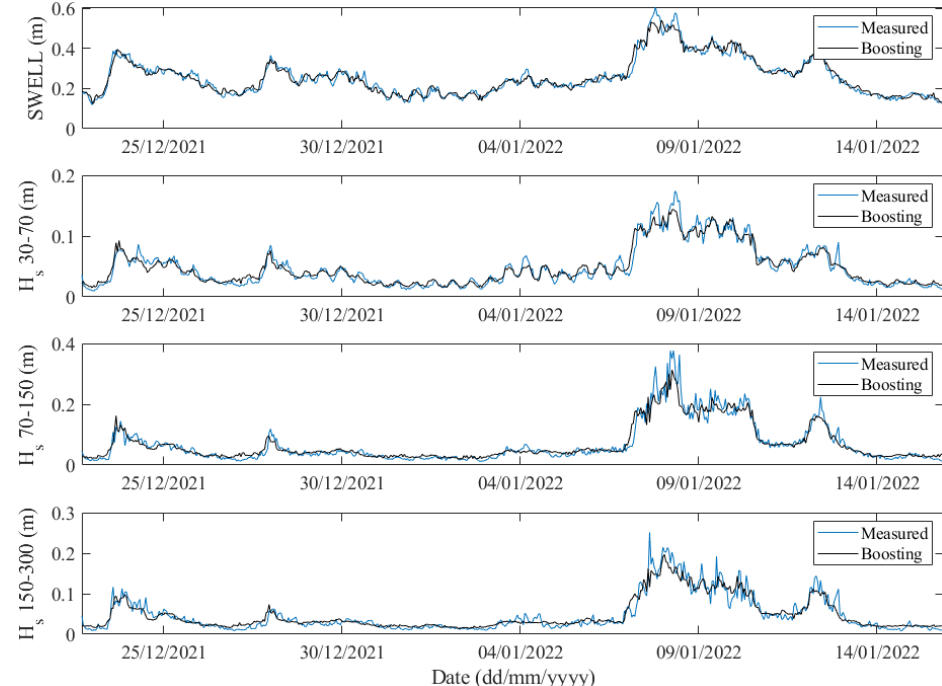
Figure 6. Measured and predicted data with the formula and with GBM of the H s in sensor S1 for the different frequency ranges.